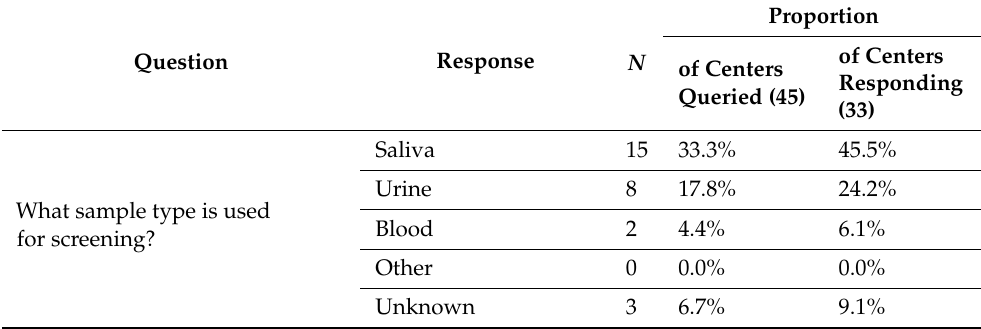
Table 5. Responses regarding congenital cytomegalovirus screening